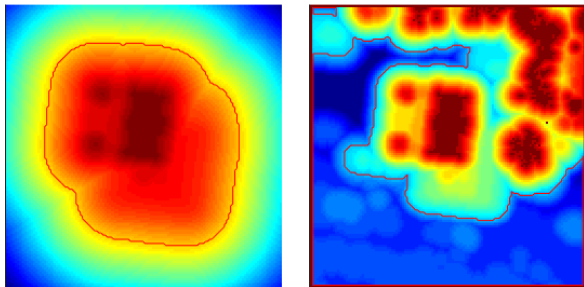
Figure 7. A putative path 𝑝 at constant distance from the building, extracted as isoline in a Z-layer of 𝑂 (red curve, left). The border of traversable space 𝑏 is extracted as isoline at the safety distance from 𝑆 in the same layer (red curve, right).